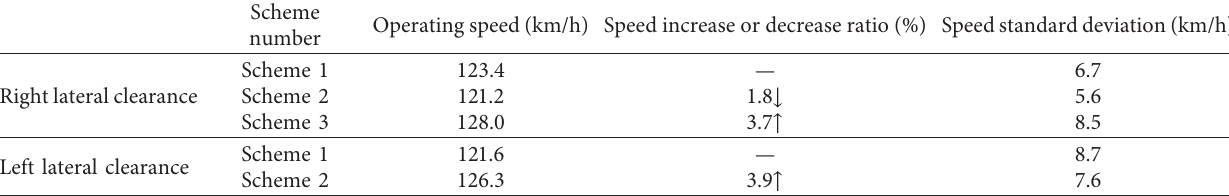
Table 9: Driving performance statistics of small car drivers with different lateral clearances.